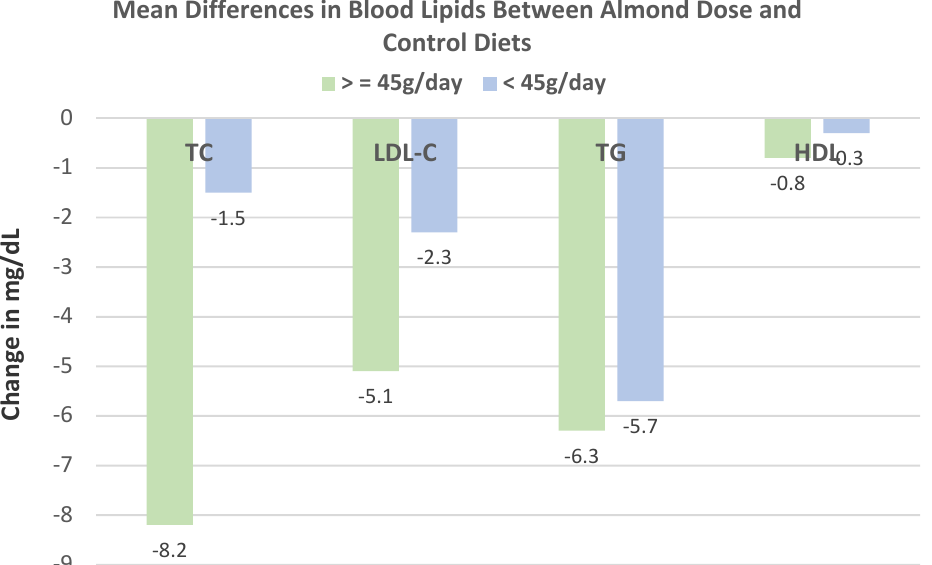
Figure 17. Meta-analysis on mean differences in blood lipids between dose of almonds and control diets for ≥ 45 g doses of TC and LDL-C p = 0.001, and TG and HDL-C p ≤ 0.188, and <45 g doses of TG p = 0.199 and TC, LDL-C and HDL-C p ≥ 0.470 [69].